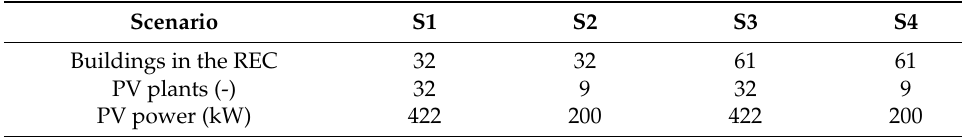
Table 4. Summary of the simulated